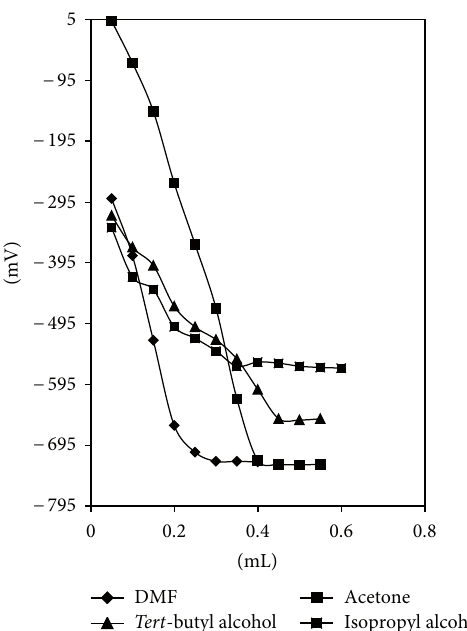
Tert -butyl alcohol F 4: Potentiometric titration curves of 0.001M solutions of compound 4b titrated with 0.05M TBAH in isopropyl alcohol, tert - butyl alcohol, DMF, and acetone at 25 ∘